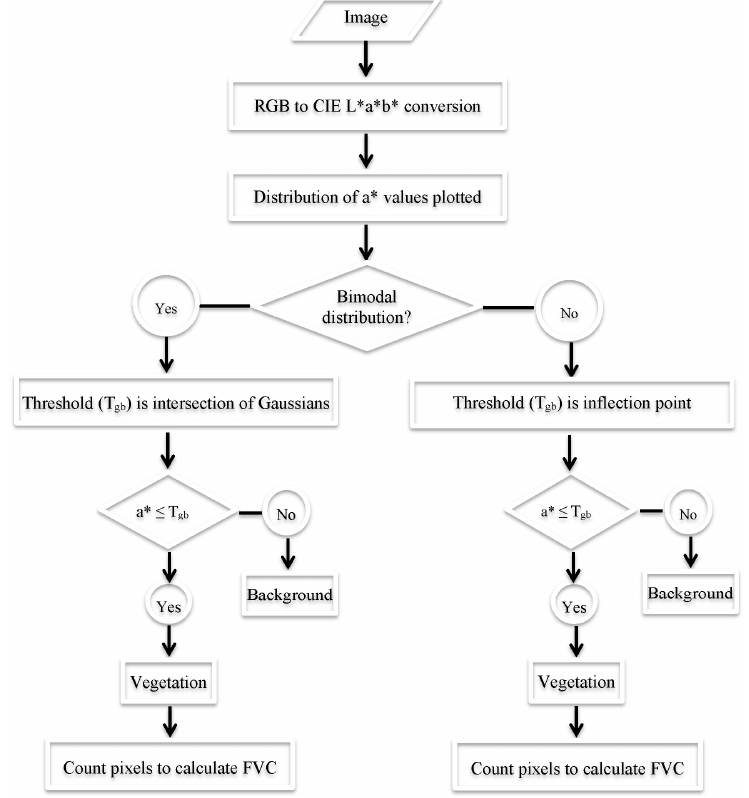
Figure 1. Flowchart of the ACE algorithm.